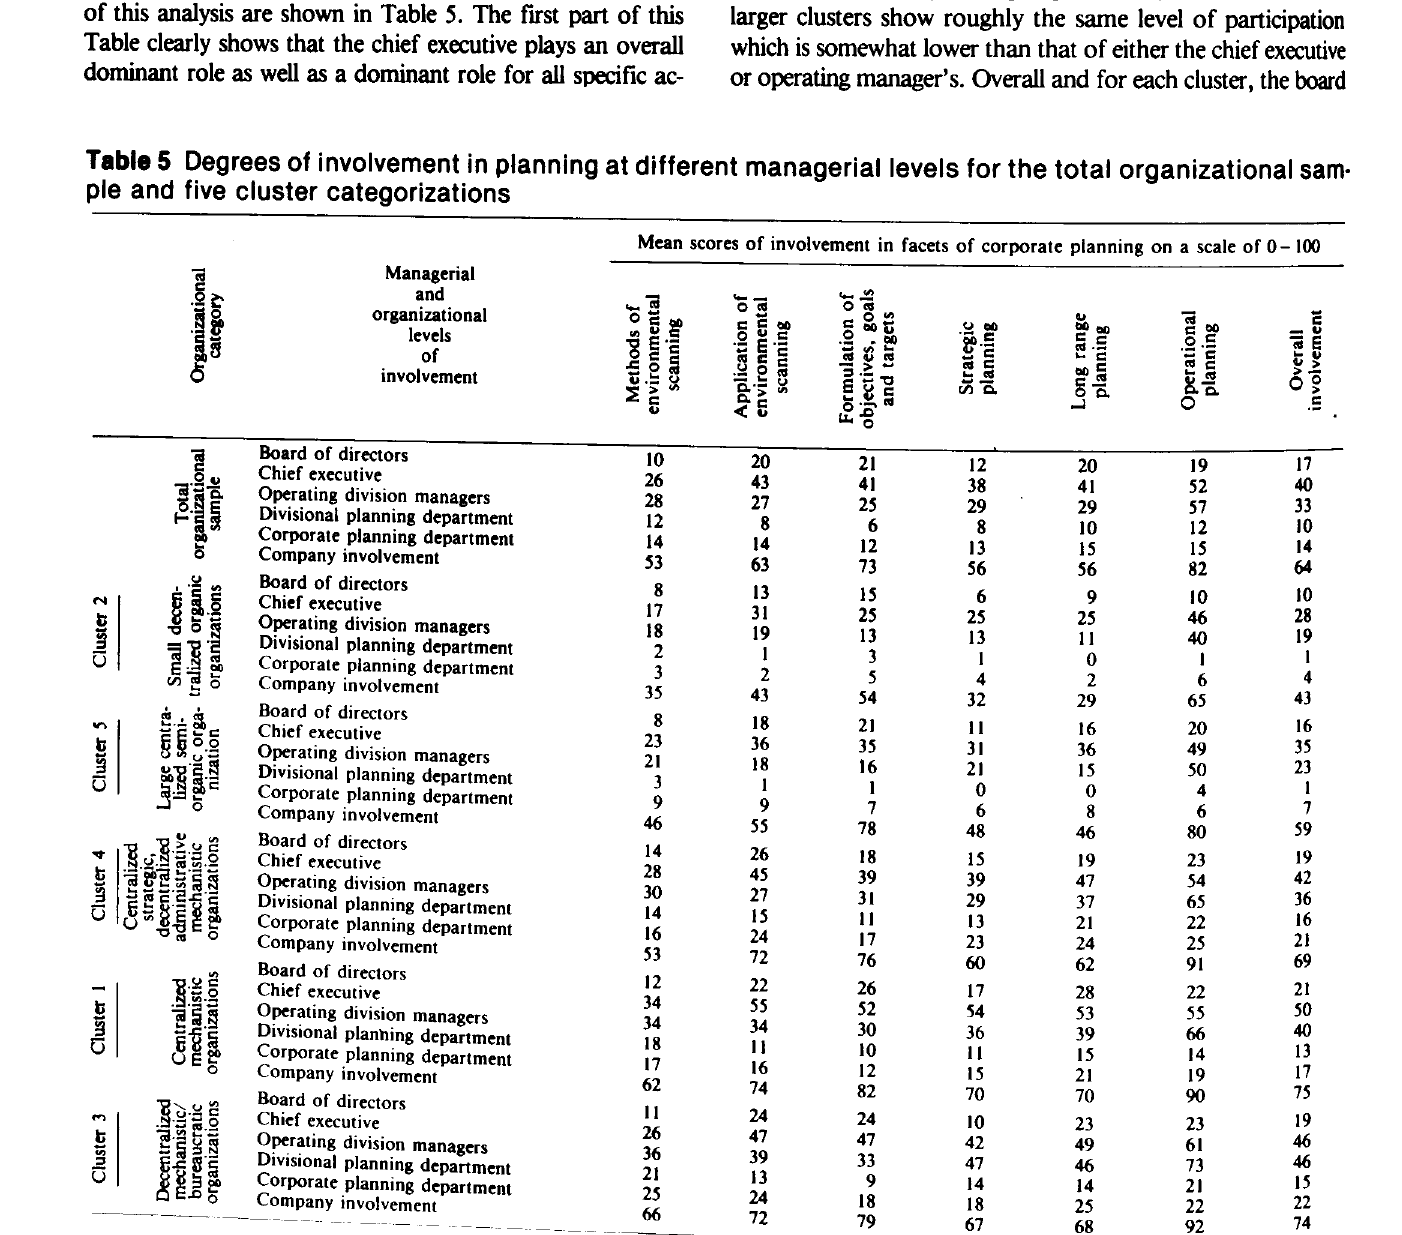
Table 5 Degrees of involvement in planning at different managerial levels for the total organizational sam- pie and five cluster